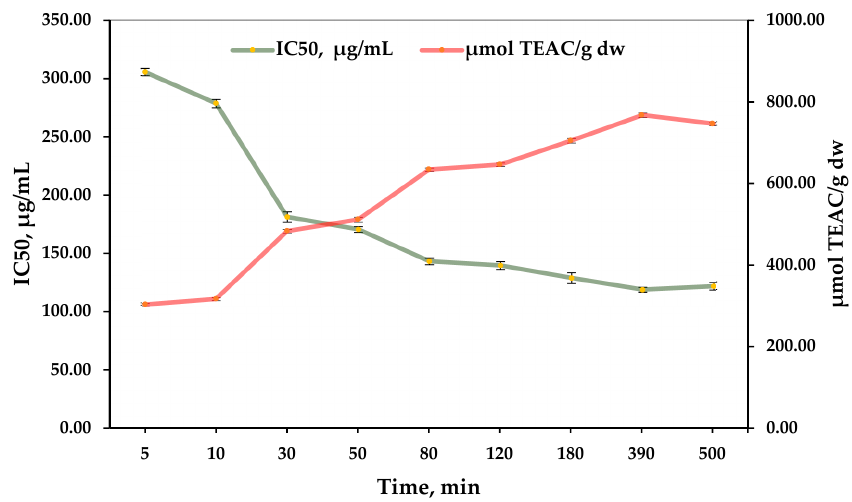
Figure 2. Kinetic curves by IC 50 in µ g/mL and µ mol TEAC/g dw of Cistus incanus leaf, stalk, and bud extracts.